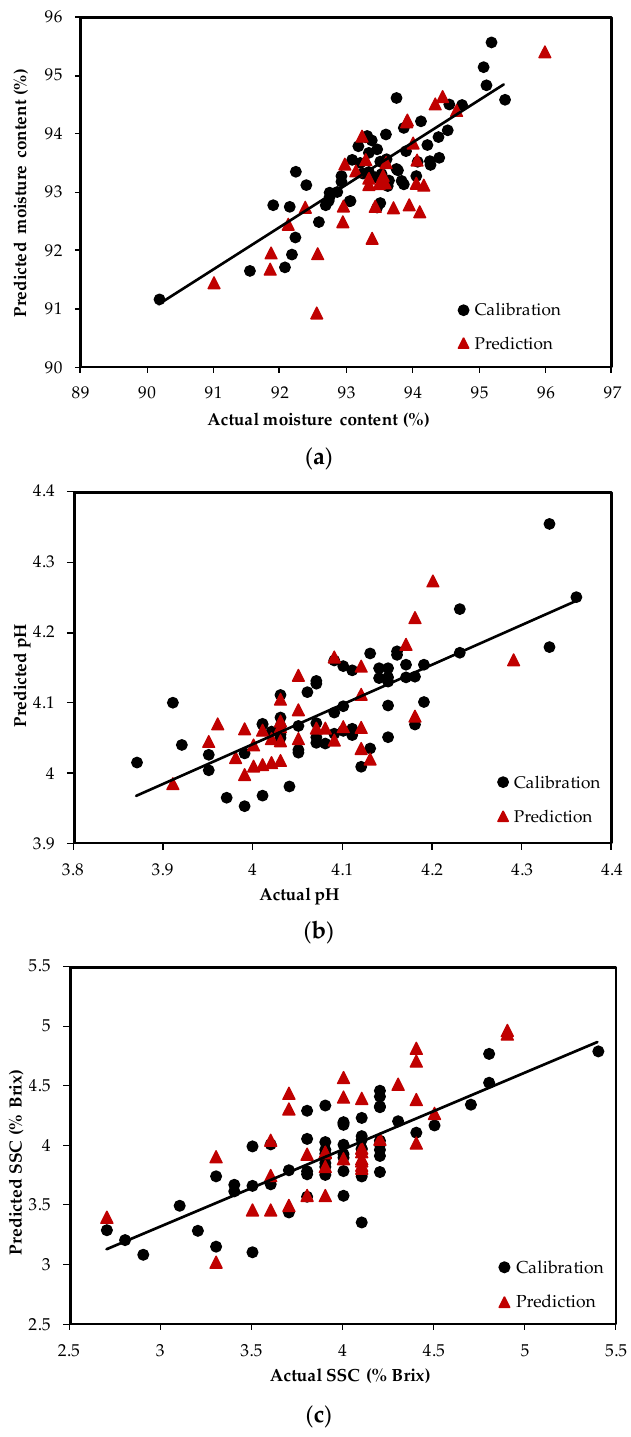
Figure 5. Prediction results of the established PLS regression models for chemical contents in intact tomatoes ( a ) moisture content ( b ) pH and ( c ) soluble solid content (SSC).